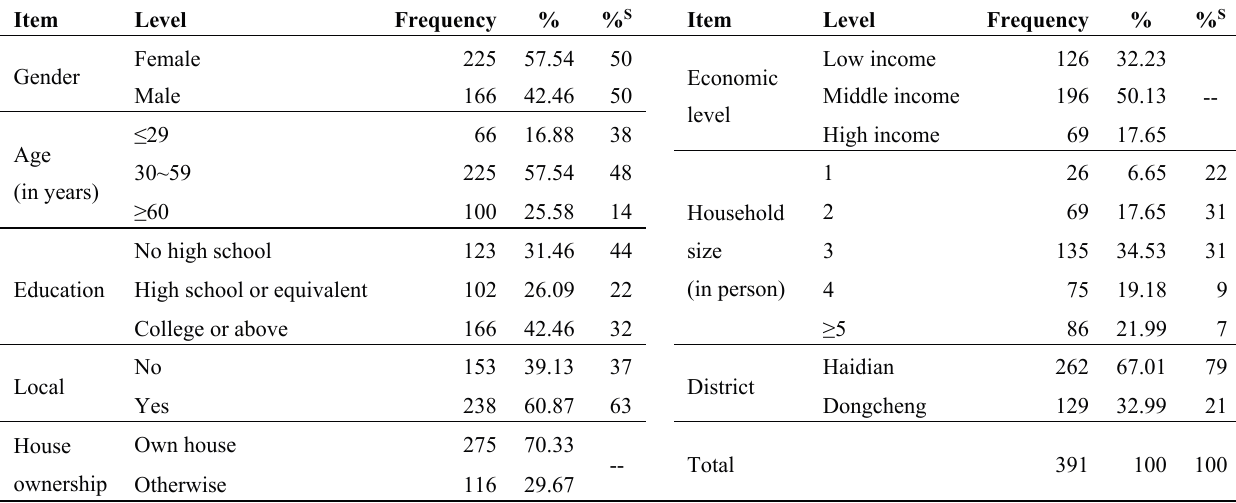
Table 1. Demographic characteristics of the sample and